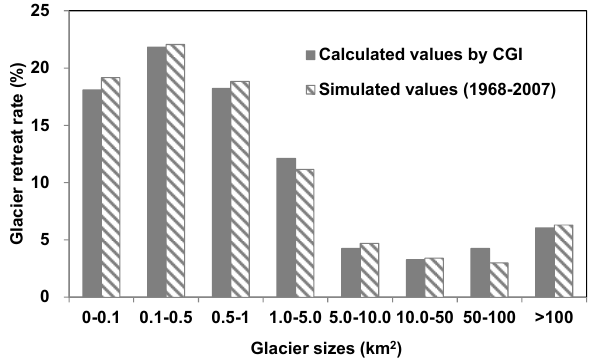
Figure 3. Comparisons between observed and simulated monthly streamflows at the Kaqun ( a ) and